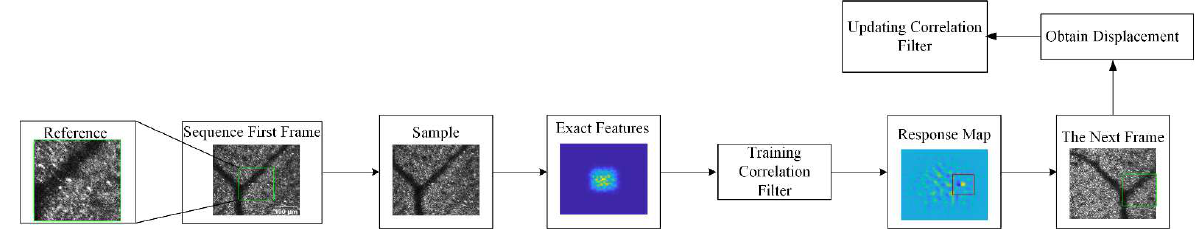
Figure 1. Efficient convolution operators for tracking (ECO) core step diagram. Here is an example of the first two frames of the sequence. The scale bar is 100 µm. The green and red boxes are the ECO reference.